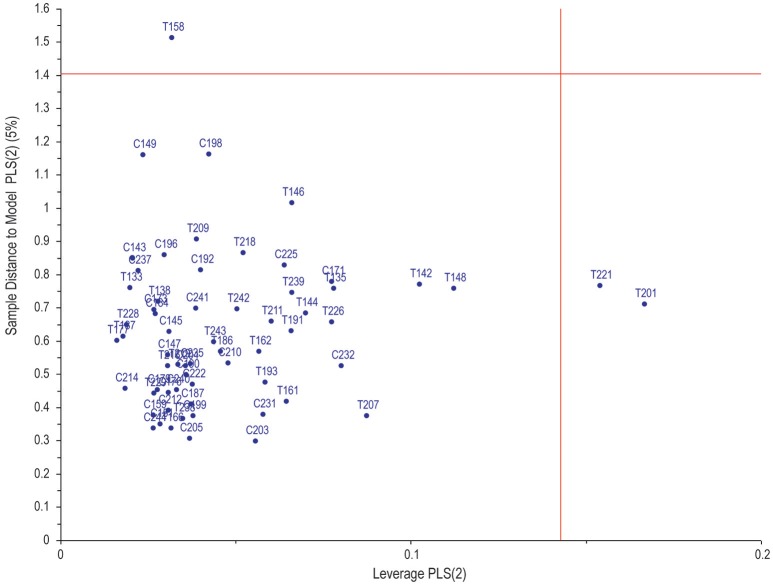
SIMCA analysis of the PLS-DA model indicating only three misclassifications for the TBM group—three false negatives predicted. Reference numbers with prefix T indicate TBM; similarly, prefix C indicates control.